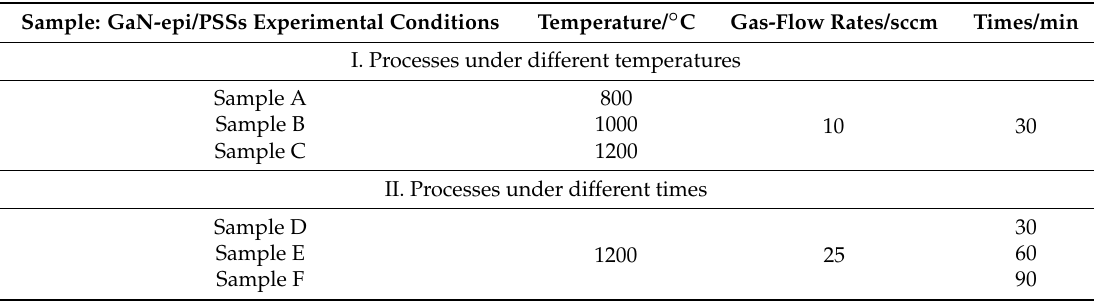
Table 1. Substrate-reclaim conditions of GaN-epi/patterned sapphire substrate (PSS).